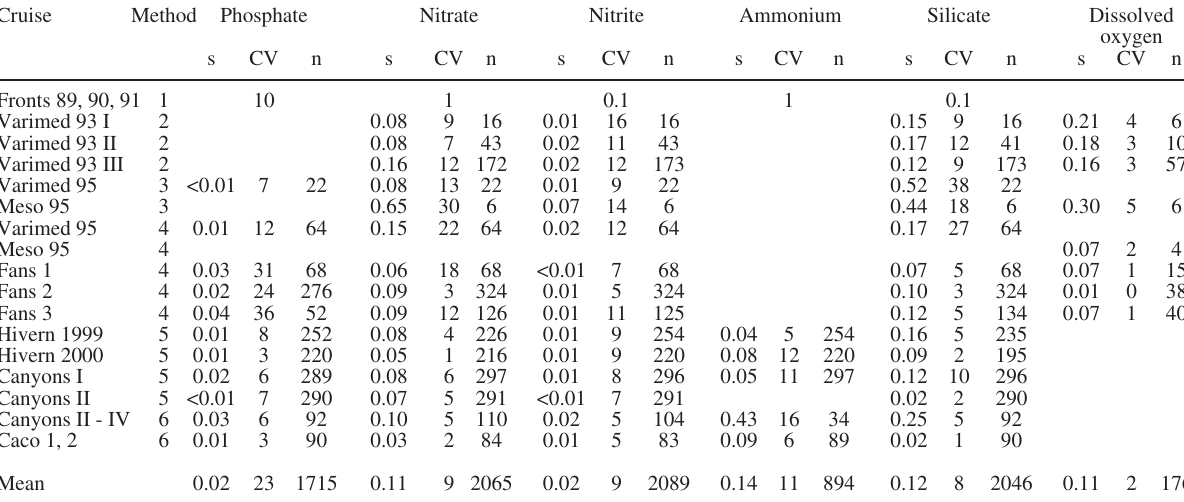
Table 3. – Analysis precision calculated using different methods: reported (1, PEPS Group, 1986) and calculated using different samples collected at the same depth (2, without any information about the Niskin bottle number); different samples collected from the same sampling Niskin bottle (3); different samples collected from different Niskin bottles closed at the same depth (4); consecutive analysis of the same sam- ple (5); and QCC using standards inserted among the samples (6). s, standard deviation (in m M for nutrients and ml l -1 for dissolved oxygen); CV, coefficient of variation (in %); n, amount of data. The mean (last row) was calculated with all the calculated